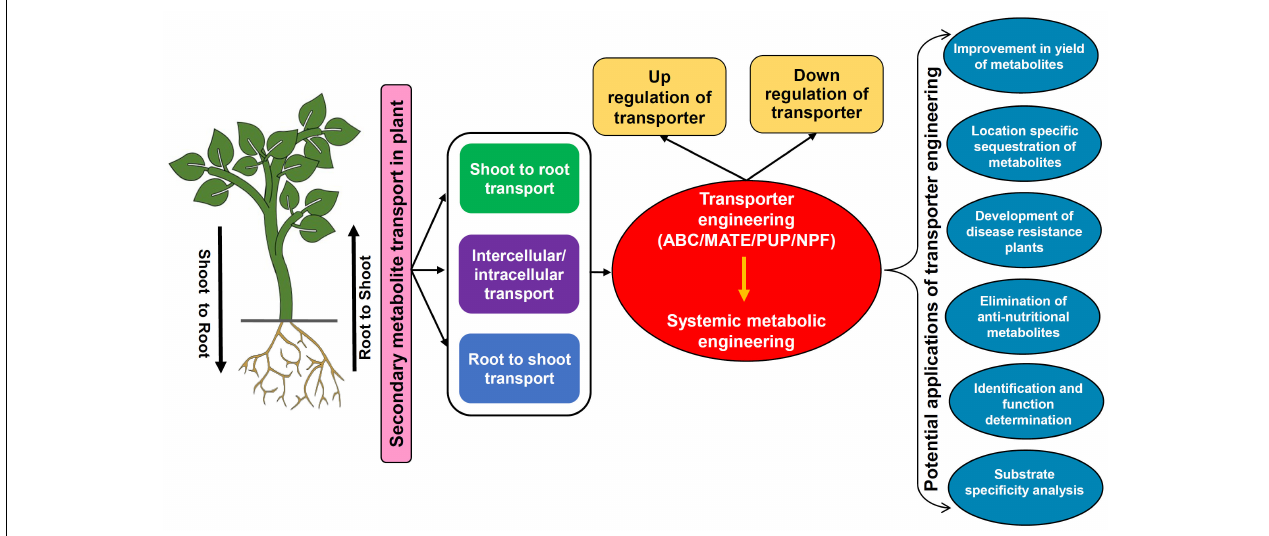
FIGURE 4 | The transporter engineering model depicting the scheme for modulation in the expression of transporters and their applications. ABC, ATP binding cassette; MATE, multidrug and toxic compound extrusion; NPF, nitrate and peptide transporter family; PUP, purine uptake